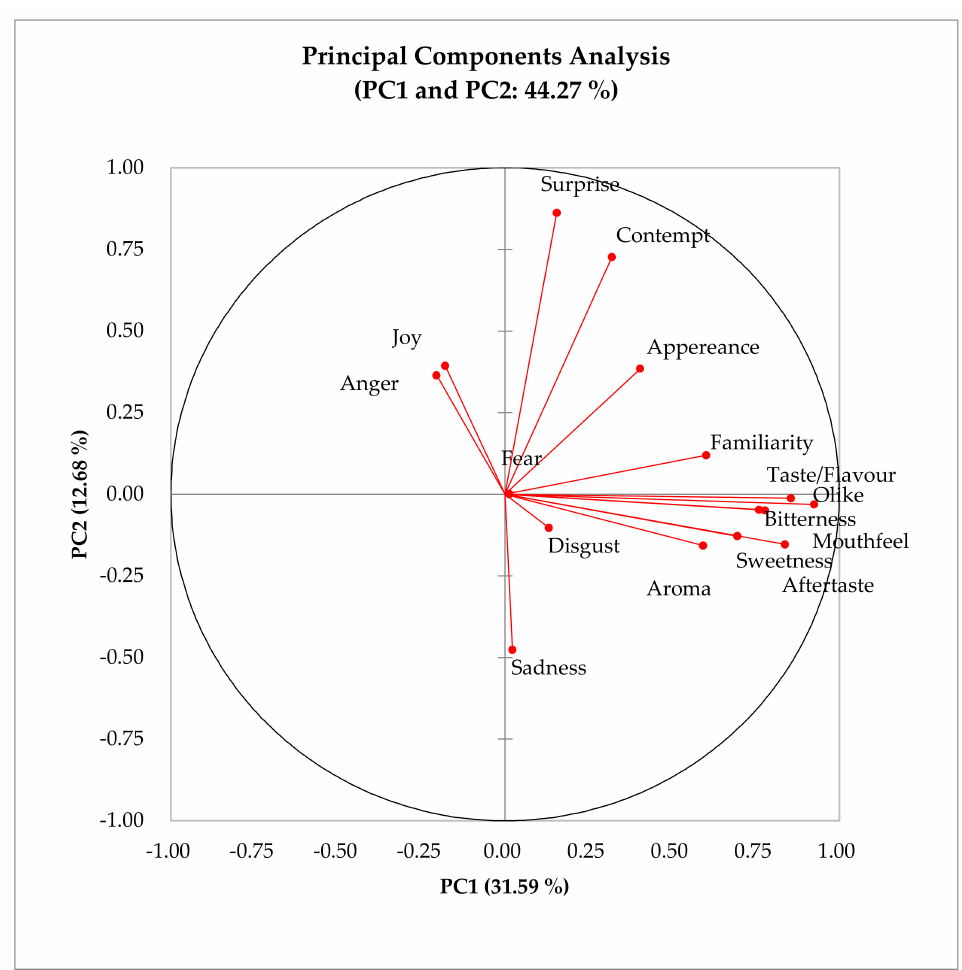
Figure 2. Principal components analysis (PCA) of the sensory attributes, familiarity, liking and emotions of energy